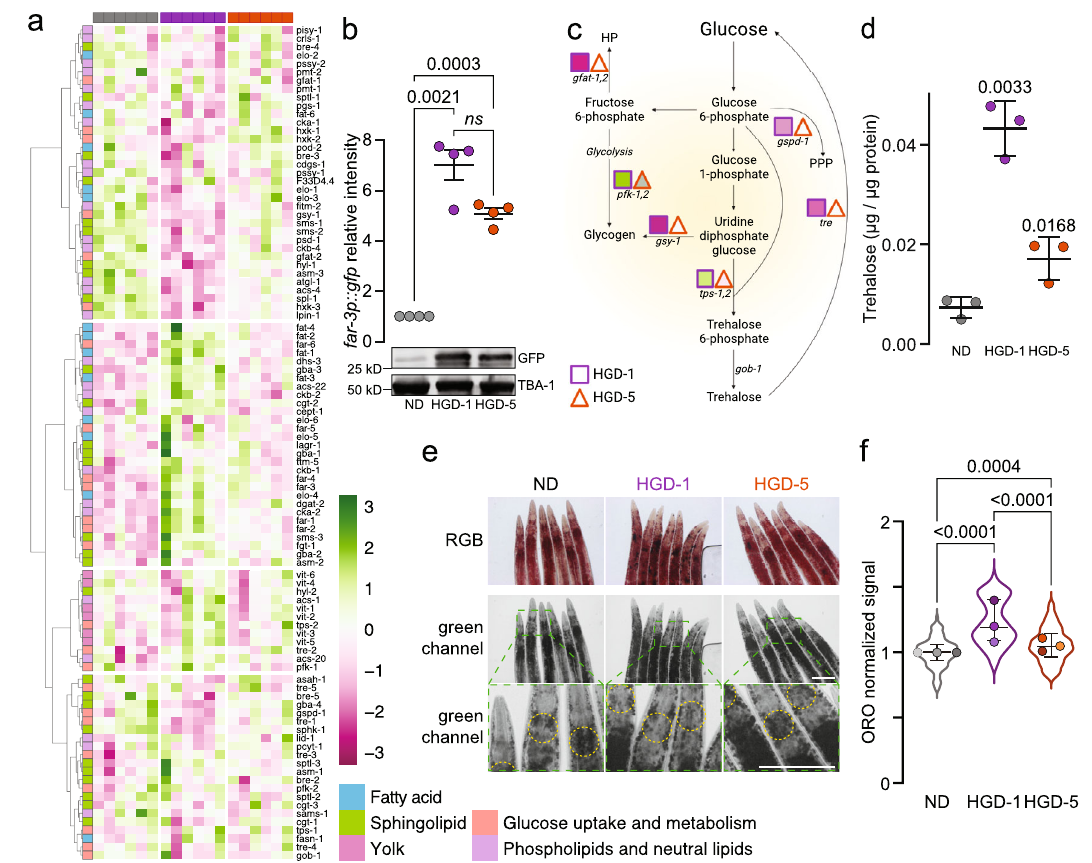
e Representative images of Oil Red O (ORO) staining of ND, HGD-1 and HGD-5 animalsharvestedonday10.Lipiddropletswerequanti fi edfromthegreenchannel withinregionsofinterest(yellow-dashedcircles)aspreviouslyreported 55 .Scalebar represents100 μ m. f Quanti fi cationofORO-stainedlipiddropletsatthepharynxof animal as in e (ND, n =127; HGD-1, n =110; HGD-5, n =112 including biological replicates). Data shown are the mean±SEM. Statistical analysis was subjected to one-way ANOVA with Tukey ’ s